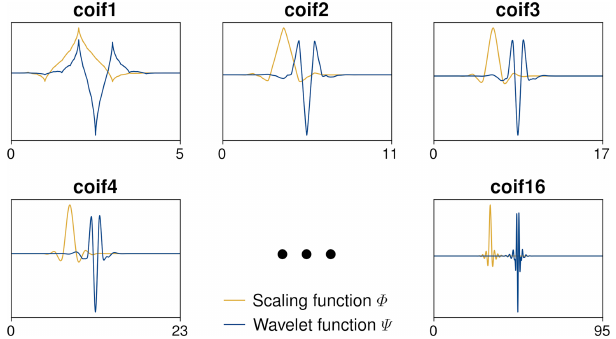
Figure A1. Scaling and wavelet functions for the coiflet wavelet